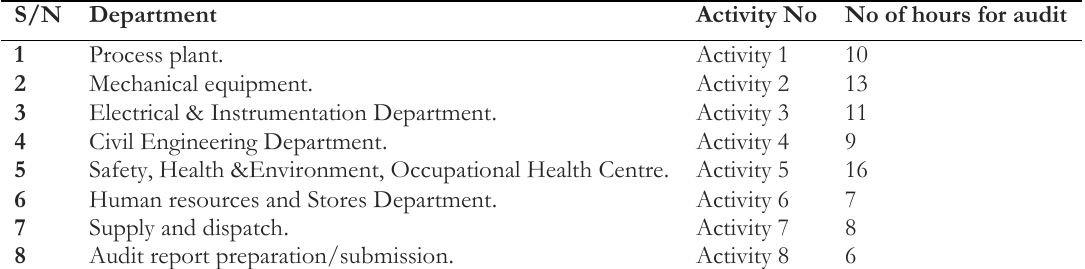
Table 1. Departments, activities and hours required for